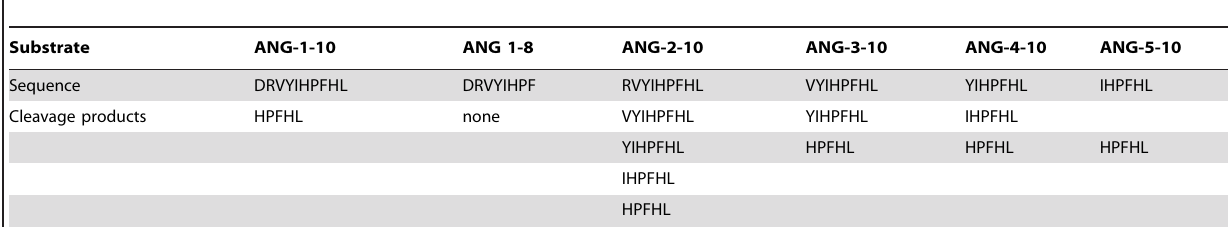
Table 2. Generation of angiotensin peptides from different angiotensin substrates by recombinant aminopeptidase N (APN).